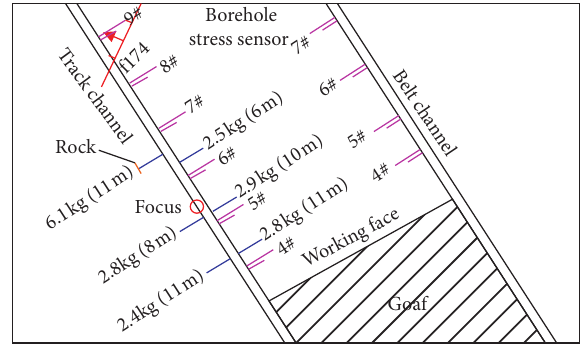
Figure 14: Cuttings inspection